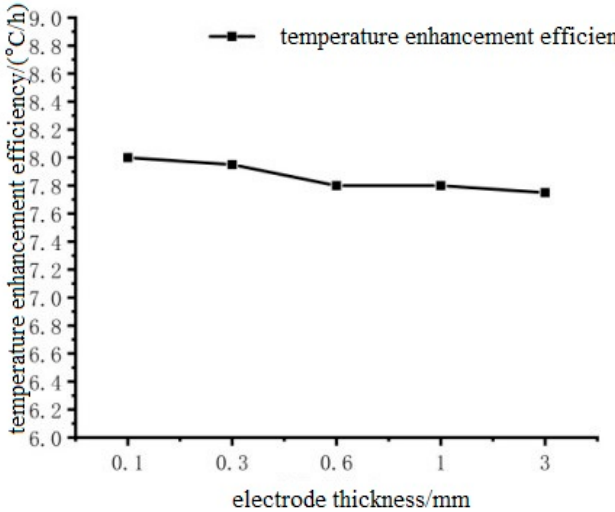
Figure 17. The relationship between electrode thickness and heating rate.